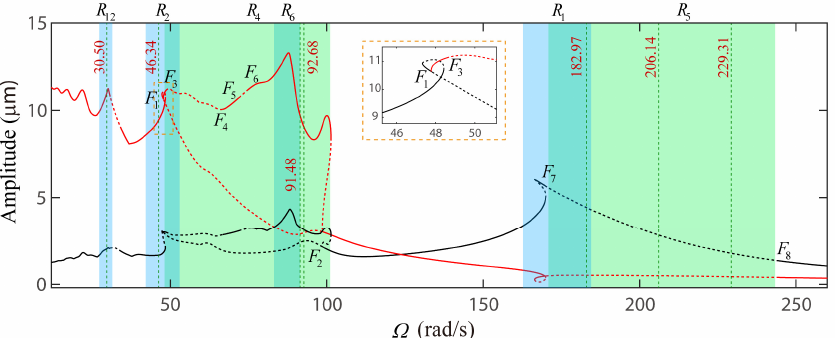
Figure 28. Stable (solid) and unstable (dashed) VC periodic peak-to-peak frequency–response curves in x (red line) and y (black line) directions.